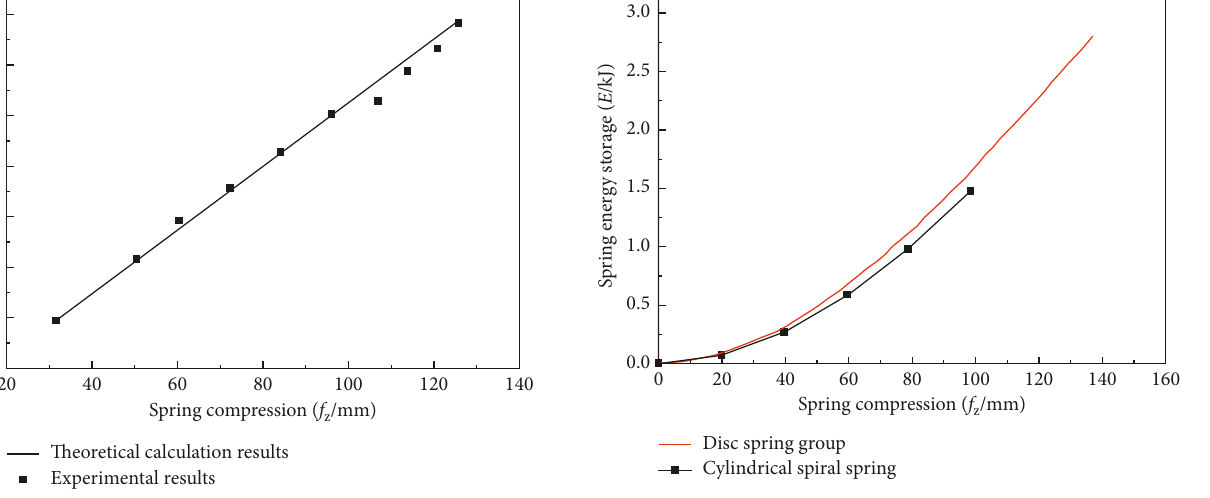
Figure 12: Comparison between the theoretical calculation of the velocity and the measured velocity as a function of spring